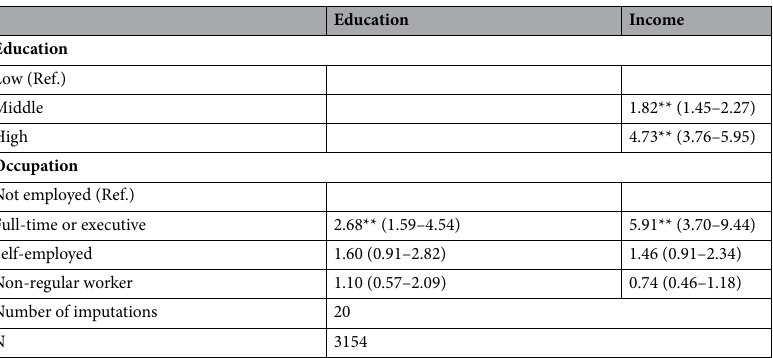
Table 4. Associations between the pairs among parental education, parental occupation, and household income. These results were estimates by multilevel ordered logistic regression, controlling for parental ages, being in a single-parent household, and the scale of a residential area and fitting a three-level model incorporating school type nested within residential areas. Values are odds ratios and 95% confidence intervals based on robust standard errors in parenthesis with *p < 0.05, **p < 0.01. The bivariate associations between the pairs among parental education, parental occupation, and household income with aforementioned controls were